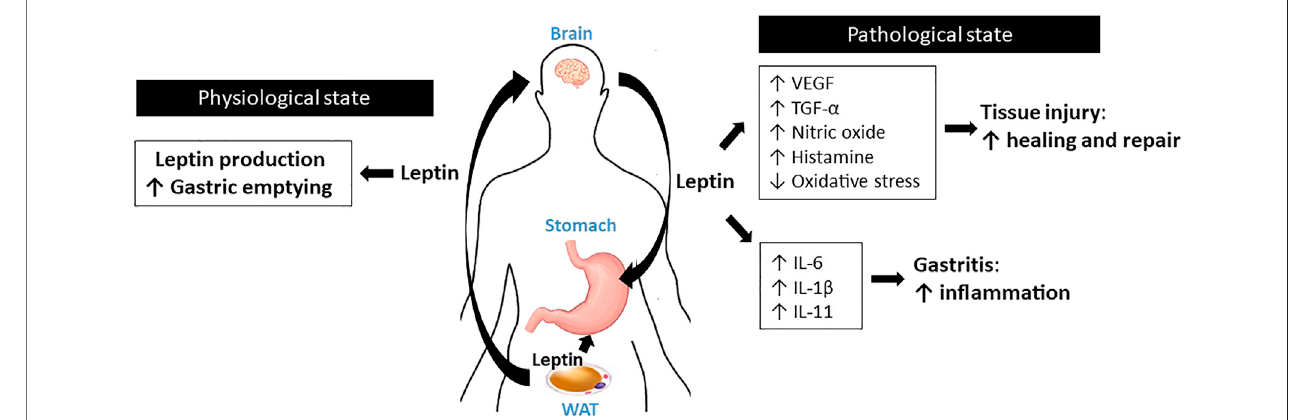
FIGURE 1 | Schematic diagram for the roles of leptin in the stomach.